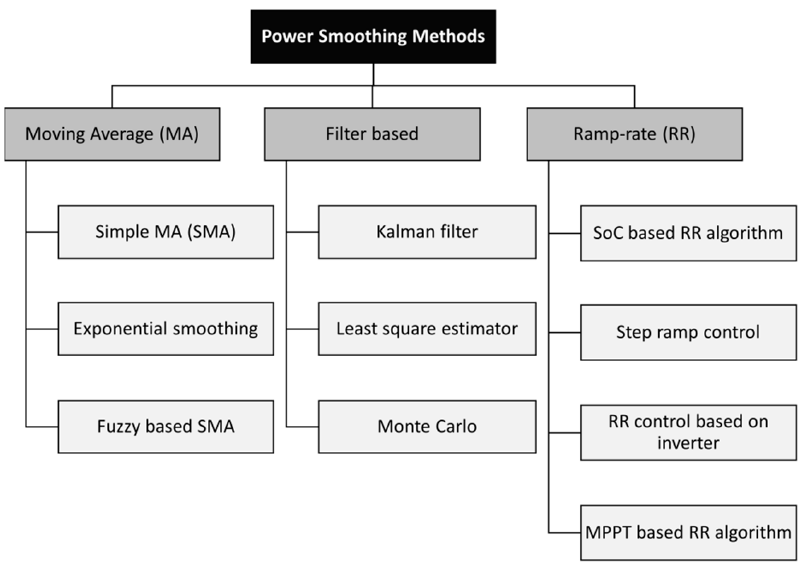
Figure 4. Wind power factor smoothing techniques to apply to BESS.